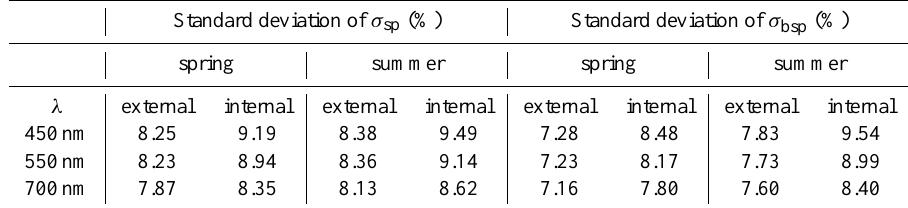
Table 6. The ratios of the amount of nephelometer-measured σ sp and σ bsp fall within the range of the corresponding calculated values based on the assumptions of internal and external mixture to the total amount of the measured values, considering the uncertainties of the calculations. σ sp σ bsp λ spring summer spring